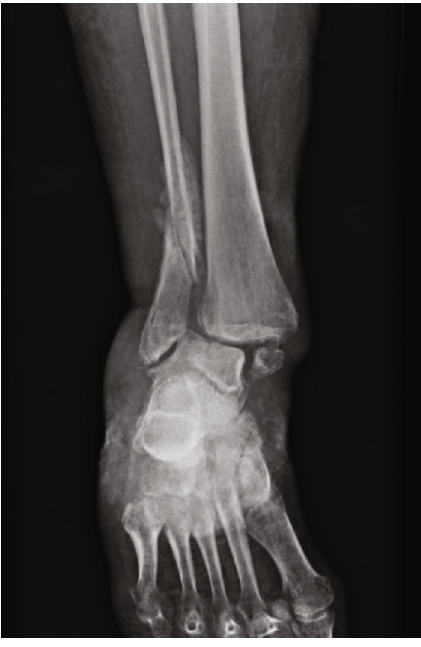
Figure 2: Progression toward chronic ankle deformity and malunion.